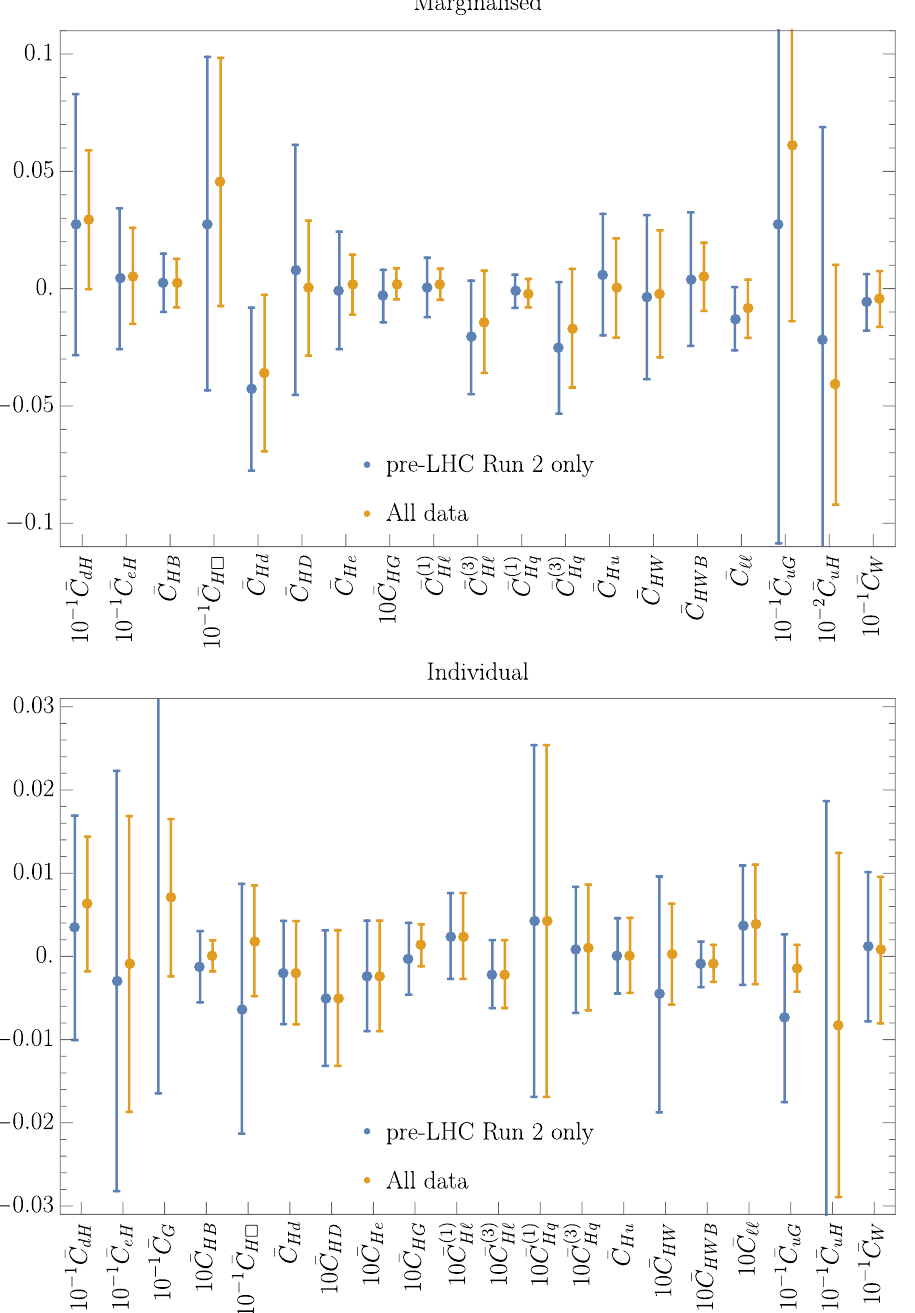
Figure 2. Results from global (cid:12)ts in the Warsaw basis (orange) including all operators simultane- ously (upper panel) and switching each operator on individually (lower panel). Also shown are (cid:12)ts omitting the LHC Run 2 data (blue). We display the best-(cid:12)t values and 95% CL ranges.